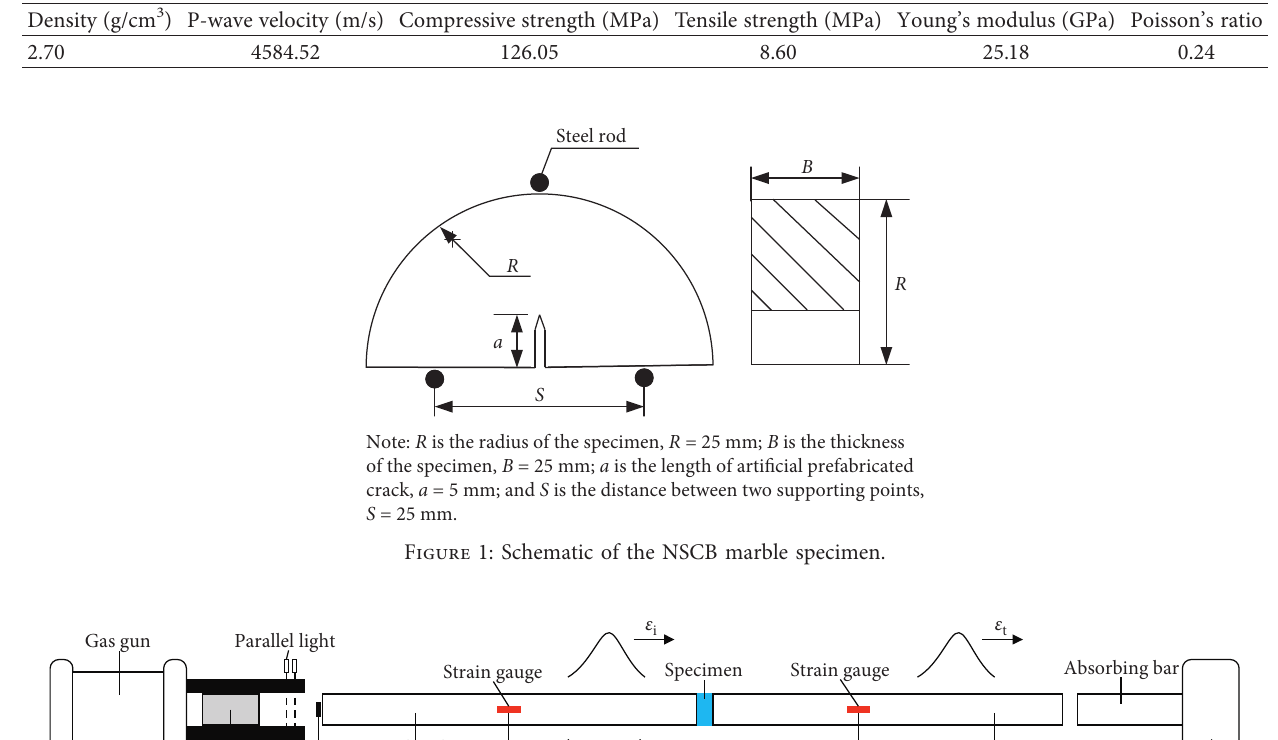
Table 1: The basic physical and mechanical properties of the marble.